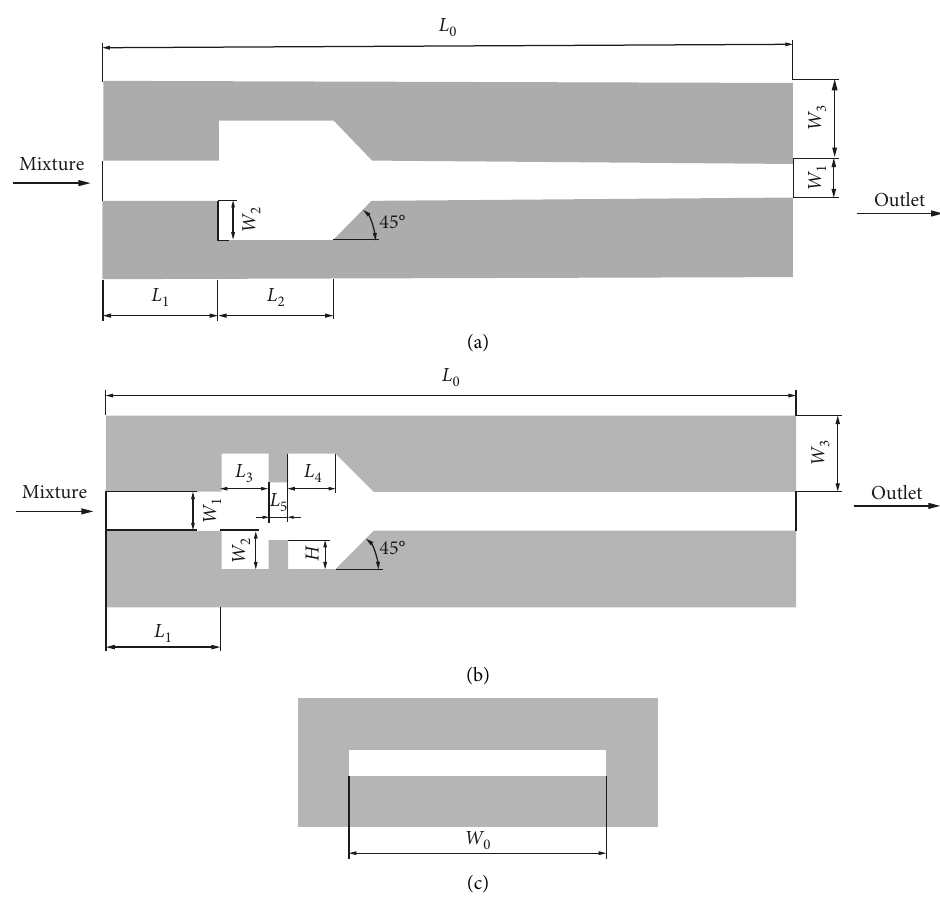
Figure 2: Schematic diagram of the microcombustor: (a) without rib, (b) with rib, and (c) combustor exit.